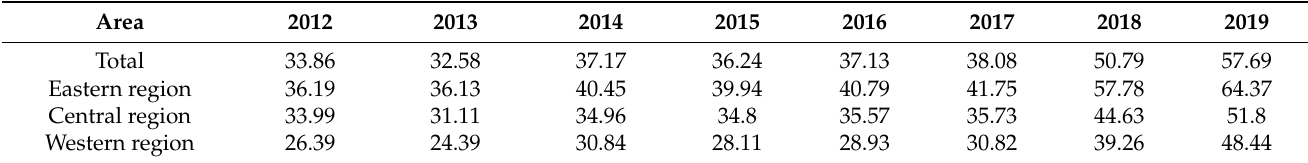
Table 4. The registration rate of GPs in China in 2012–2019 (%).